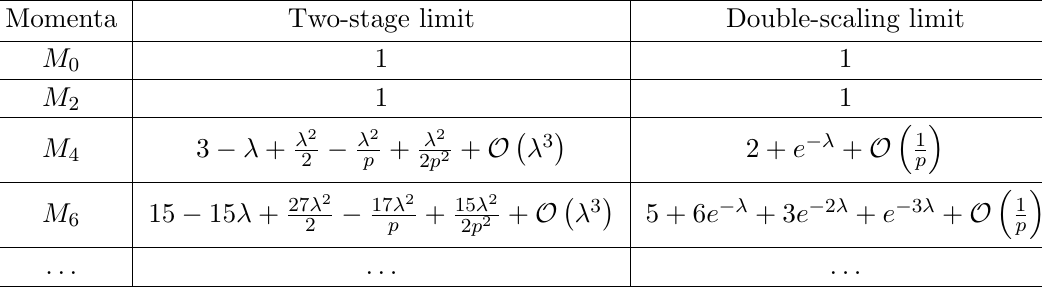
Table 1. Low order comparison between the iterated limit results of [56] and the predictions